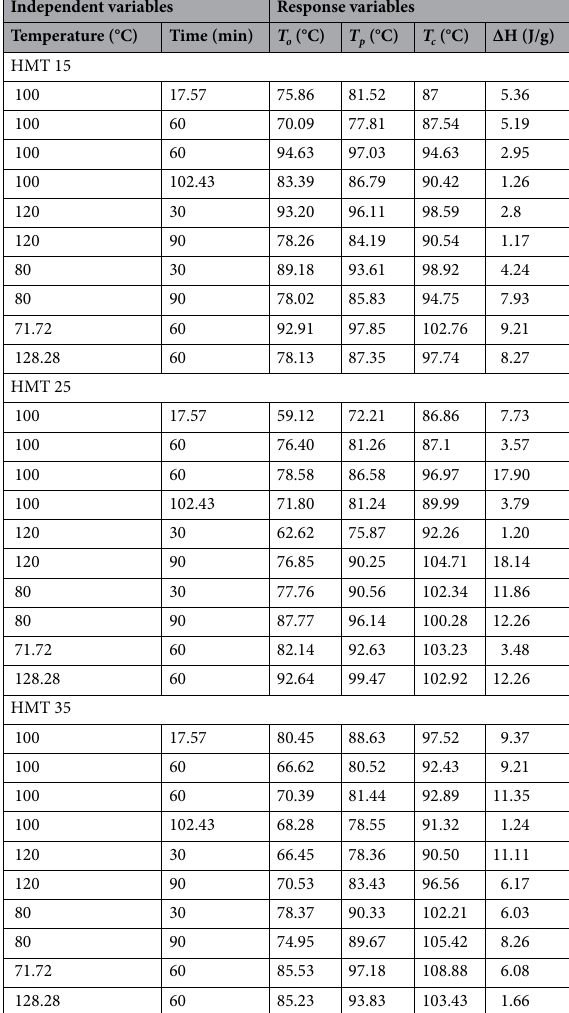
Table 7. Levels of process variables and values of gelatinization for heat-moisture treated Bambara groundnut under different treatment conditions. T o (°C): onset temperature; T p (°C): peak temperature; T c (°C): conclusion temperature; ∆H (J/g): gelatinization